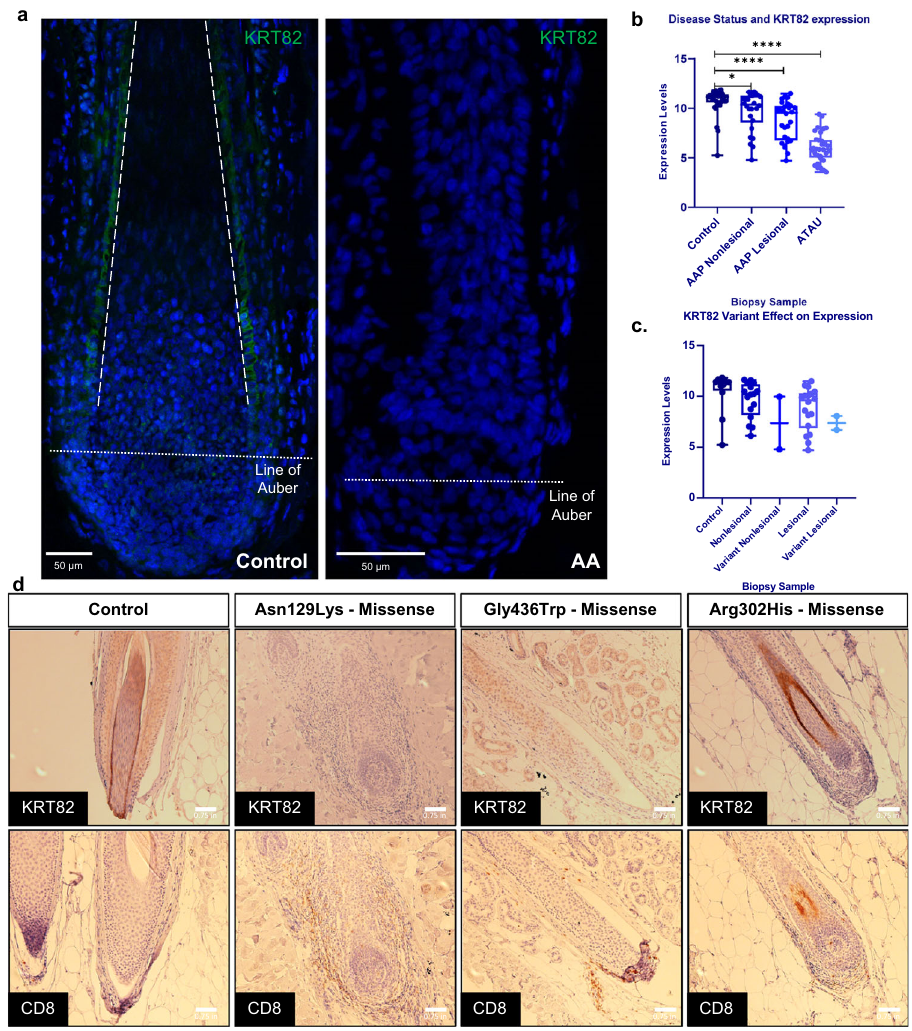
Fig. 7 Functional KRT82 expression is reduced in AA HF and skin. a IF staining of KRT82 (green) in human healthy control and AA HF. Dashed line outlines the cuticle, dotted line represents the Line of Auber. IF staining with similar results was repeated in 1 additional control sample and 2 additional AA samples (biological replicates) b RNA expression of KRT82 from whole skin scalp biopsies of control, AAP nonlesional sites, AAP lesional sites, and AT/ AU sites. Each circle represents one sample. Statistical analysis was performed using two-tailed unpaired t -test with Welch ’ s correction. * p = 0.028, **** p < 0.0001. n = 98 individuals (36 controls, 30 AAP, 32 ATAU). c Scalp RNA expression of patients carrying KRT82 variants at nonlesional (Variant Nonlesional) and lesional (Variant Lesional) sites compared to AA patients without KRT82 variants (Nonlesional and Lesional) and controls without AA or KRT82 variants. n = 32 individuals (12 controls and 20 AAP patients). Expression data is displayed in boxplots in which each sample data point is represented by individual dots; the center line denotes the median; upper and lower limits of the box denote 75th and 25th percentiles, respectively; and the whiskers indicate the dataset maximum and minimum. d IHC of KRT82 and CD8 in healthy control and lesional biopsies in three AA patients with missense variants. AA biopsies are from individual patients and serve as 3 biological replicates. Staining in another control biopsy was not repeated; however, images were taken of other hair follicles, serving as technical